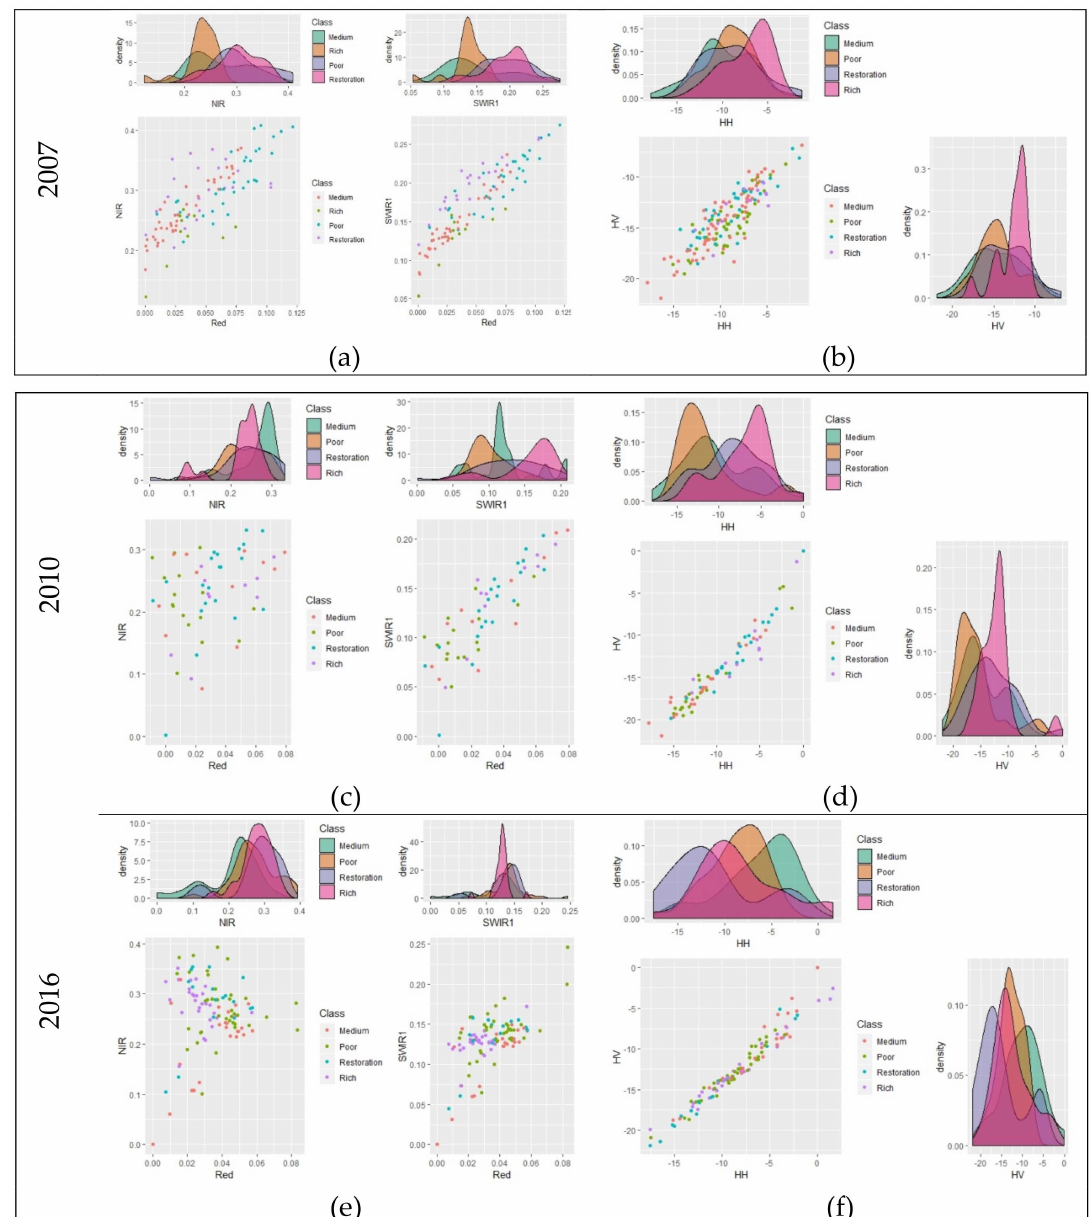
Figure A1. Distribution and density of some parameters (HH and HV signals in decibels for SAR data, and red, near-infrared, and shortwave infrared 1 in reflectance for Landsat data) in four forest types in three years 2007 ( a , b ), 2010 ( c , d ), and 2016 ( e , f